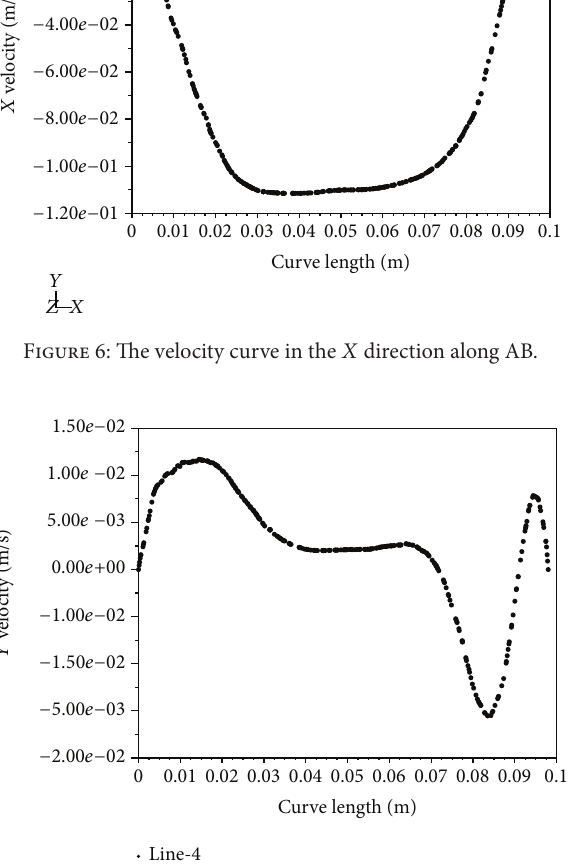
Figure 7: The velocity curve in the 𝑌 direction along AB.